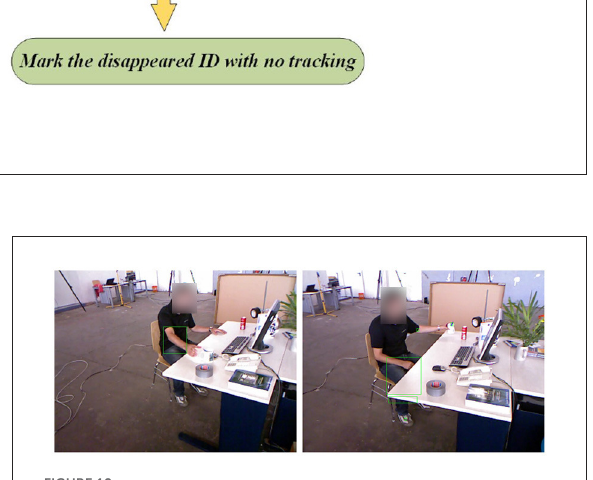
FIGURE10 Dynamic detection performance effect of the data